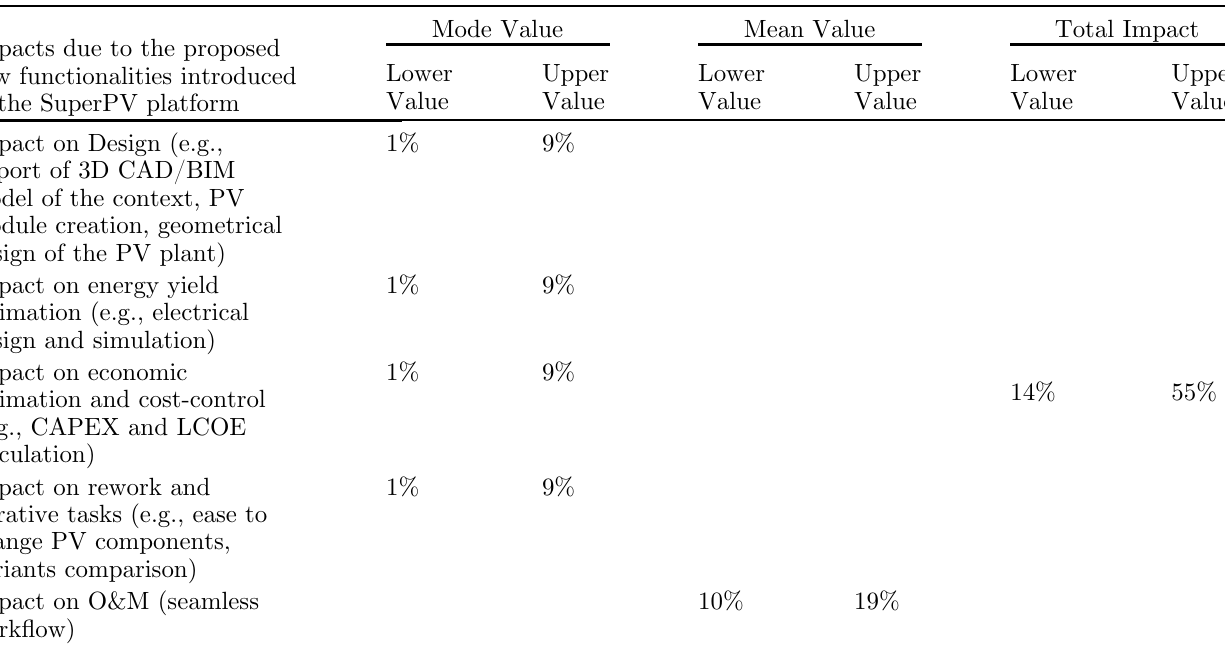
Table 1. Potential cost reduction impact of SuperPV platform depending on the engineering design step and